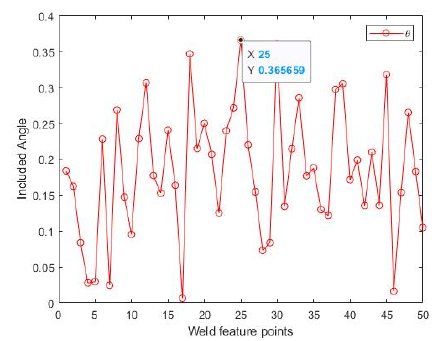
P P and b . P P P P and b . and b .